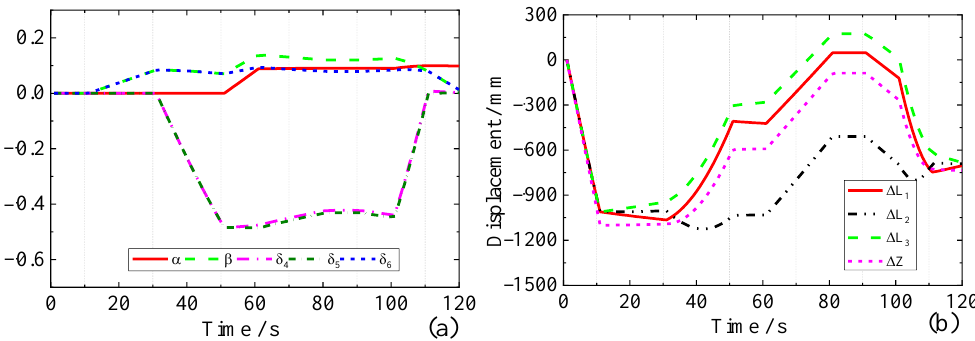
Figure 6. Lifting left outboard BB joint inverse kinematic solution ( a ); displacement inverse kinematic solution ( b ).